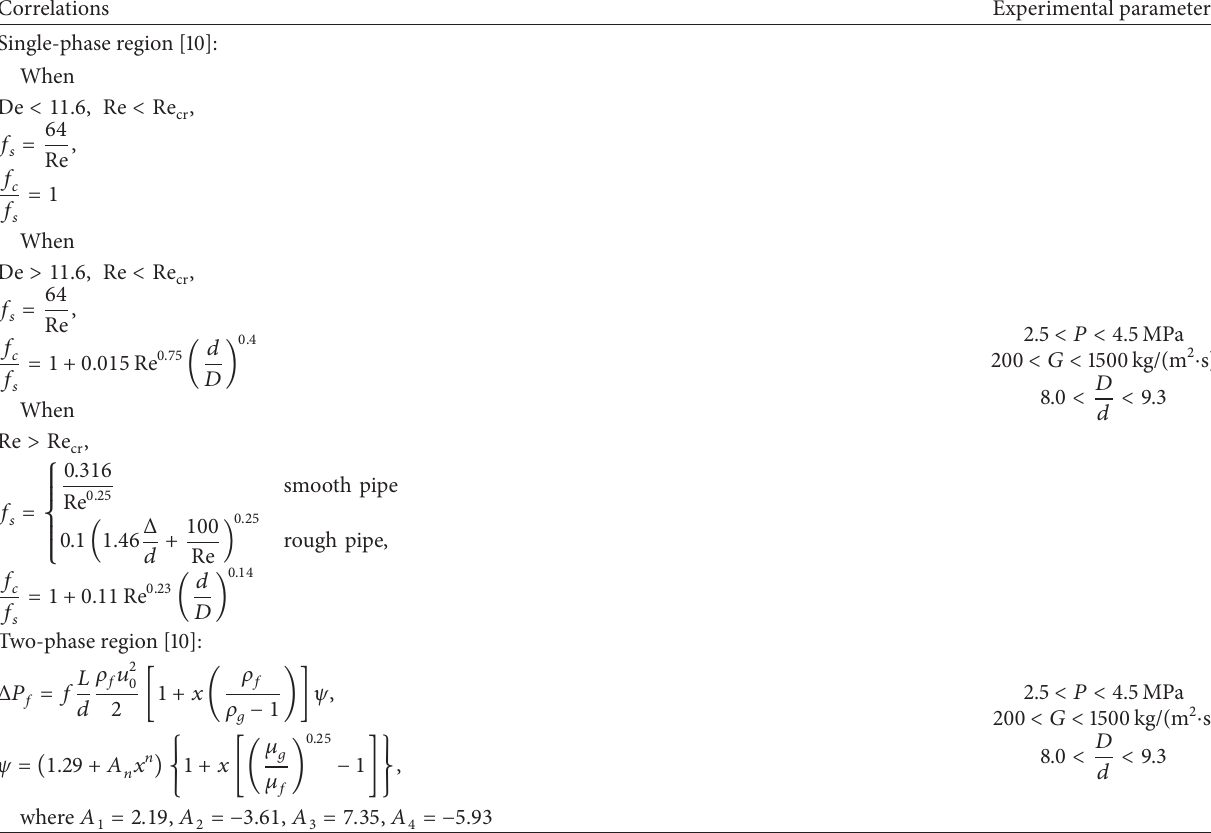
Table 2: Frictional pressure drop correlations in H-OTSG.